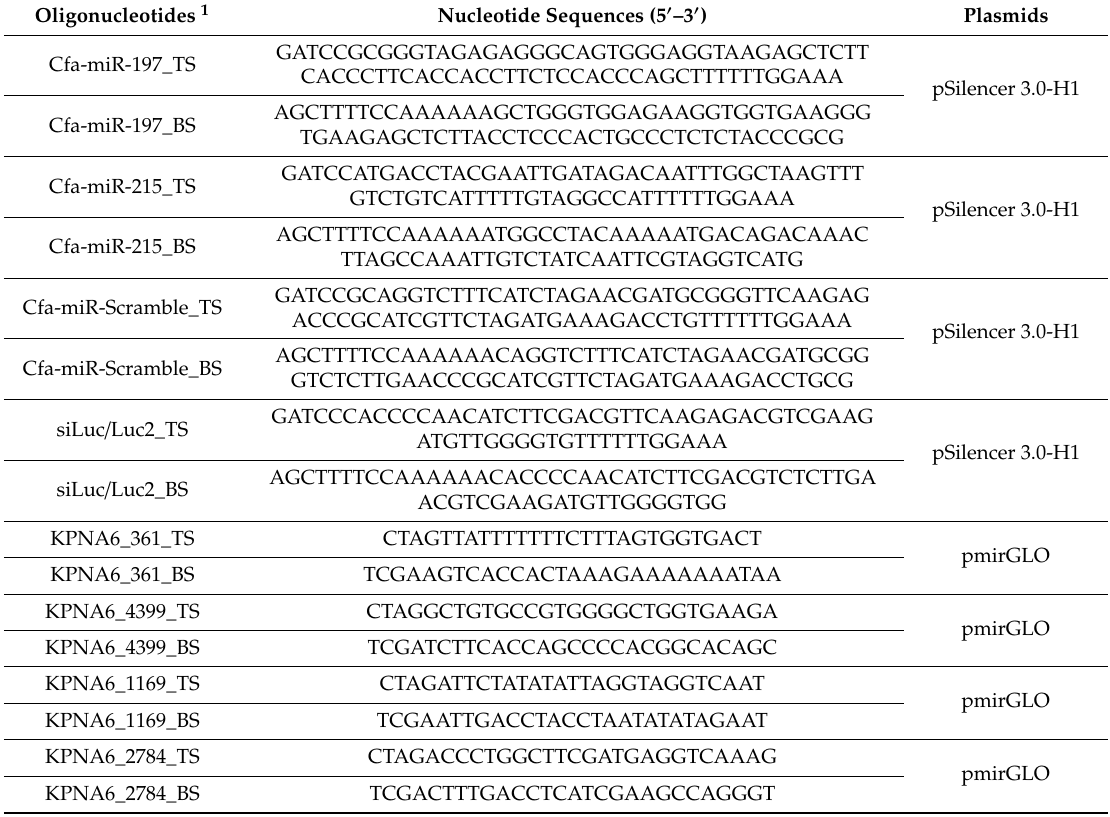
Table 2. Oligonucleotides used for construction of silencing and reporter plasmids. Oligonucleotides